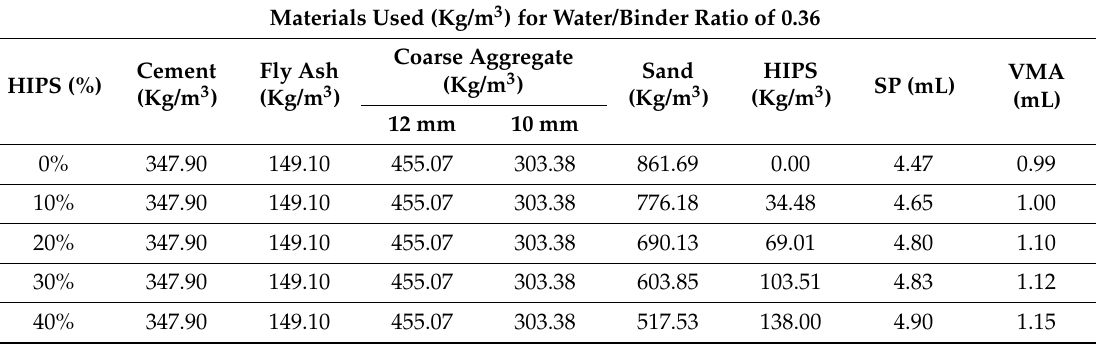
Table 2. Mix proportions with different % of High impact polystyrene (HIPS) aggregates in concrete. Materials Used (Kg/m 3 ) for Water/Binder Ratio of 0.36